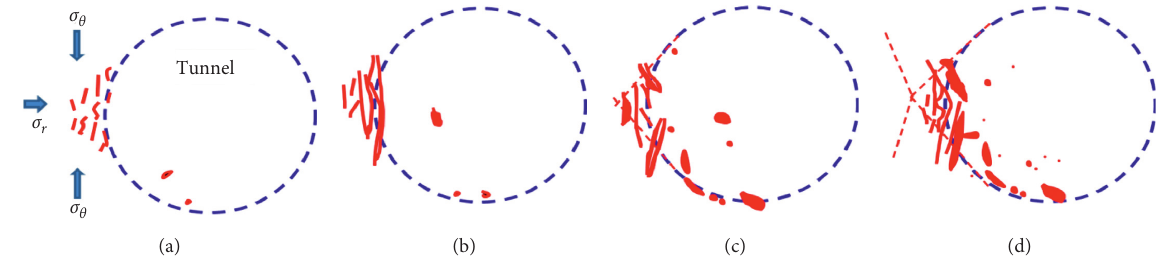
Figure 12: Video capture of the failure process in the sandstone cave wall, , (a) 16 ′ 17.12 ″ ( σ (c) 19 ′ 28.26 ″ ( σ z � 37.12MPa), (d) 22 ′ 18.18 ″ ( σ z � 45.83MPa), (e) 24 ′ 25.16 ″ ( σ z � 52.05MPa), (f) 27 ′ 36.38 ″ ( σ z � 61.40 MPa), (g) 29 ′ 44.12 ″ ( σ z � 67.62MPa), (h) 32 ′ 33.25 ″ ( σ z � 76.01 MPa), (i) 33 ′ 13.22 ″ ( σ z � 78.87MPa), (j) 34 ′ 50.48 ″ ( σ z � 83.99MPa).